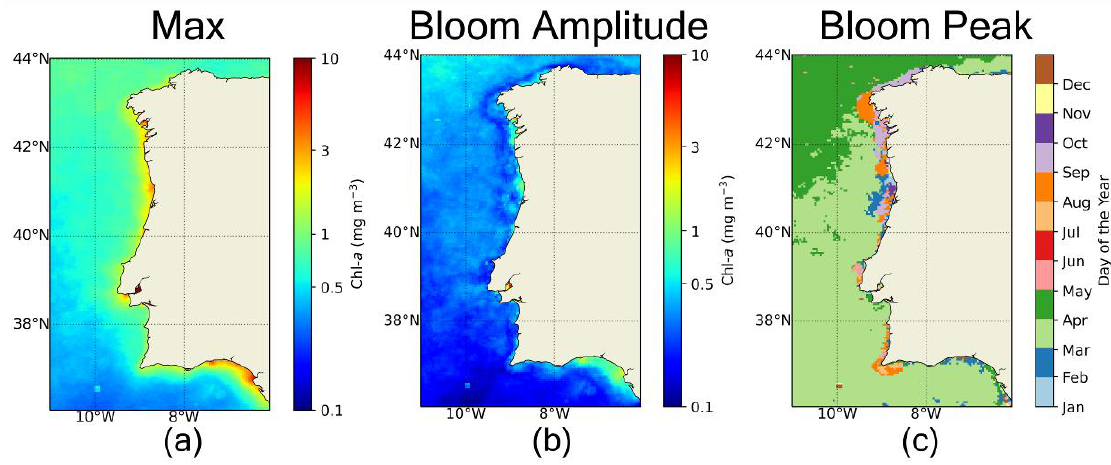
Figure 4. ( a ) Max yearly chl- a (mg m − 3 ); ( b ) mean bloom amplitude (mg m − 3 ); and ( c ) mean bloom peak date (i.e., peak chl- a concentration) calculated for the period 1998 – 2018.